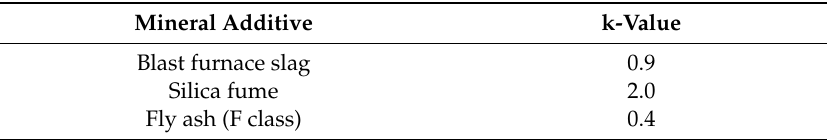
Table 3. k-values for selected mineral additives [36].